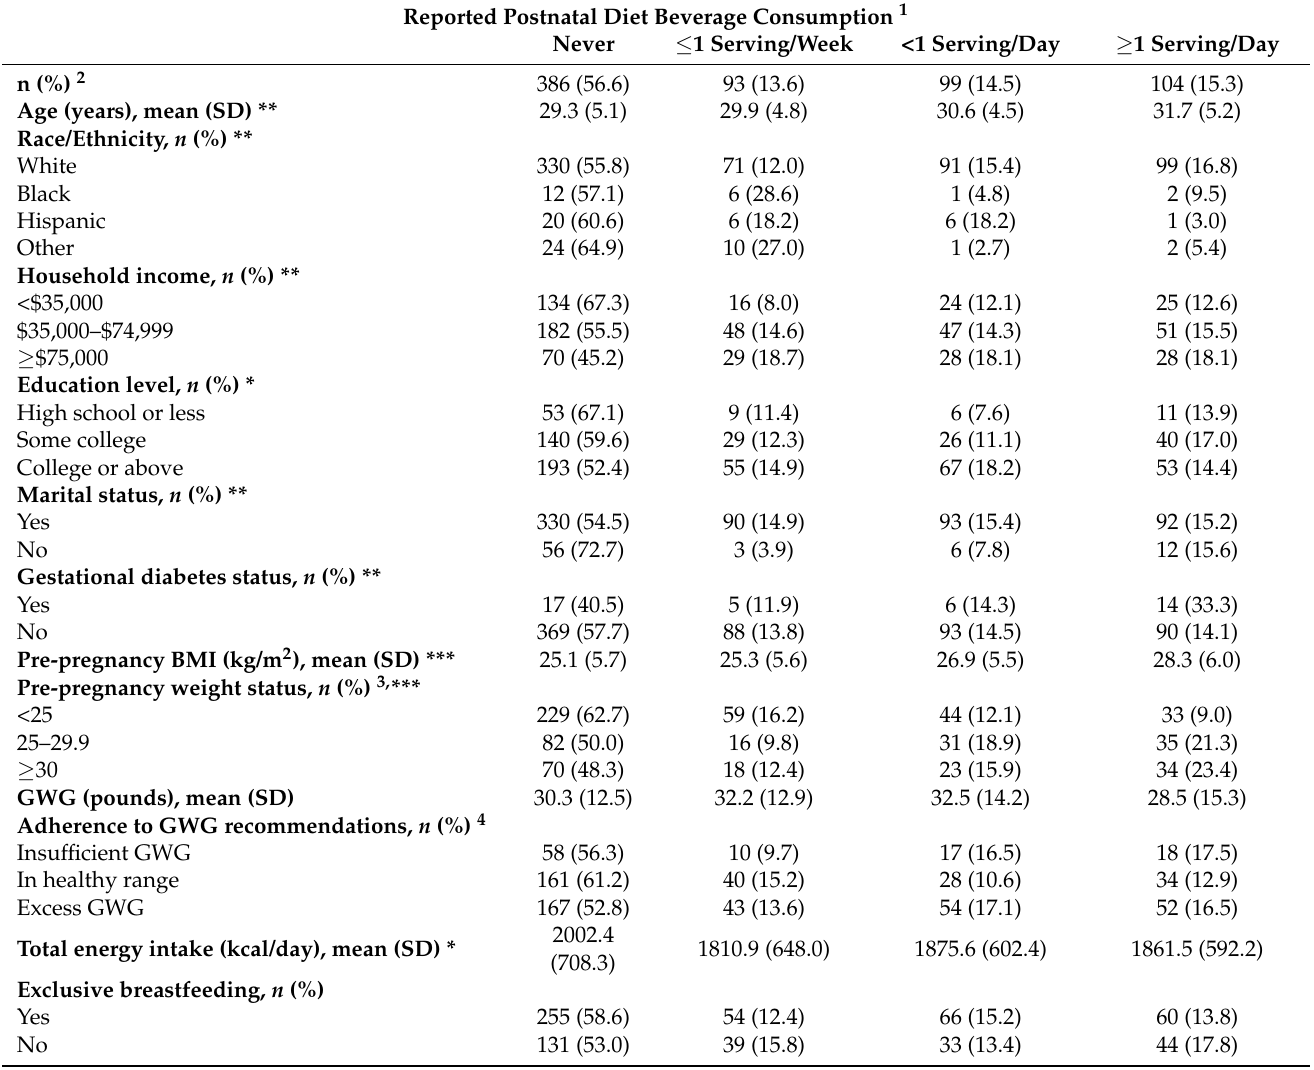
Table 1. Maternal characteristics by reported postnatal diet beverage consumption ( n =